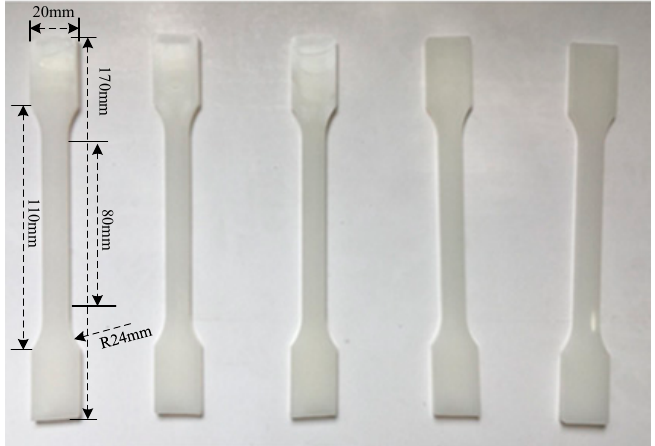
Figure 4. Image of tensile test specimens.